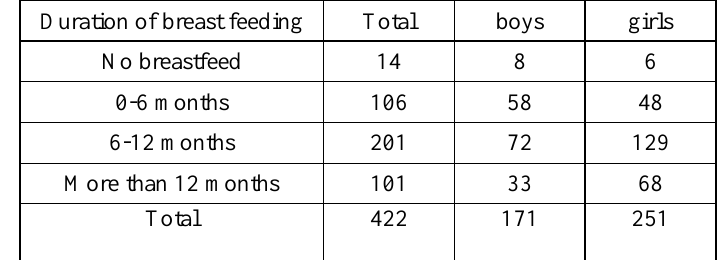
Table 1 : Distribution of the sample according to gender and duration of breastfeeding.